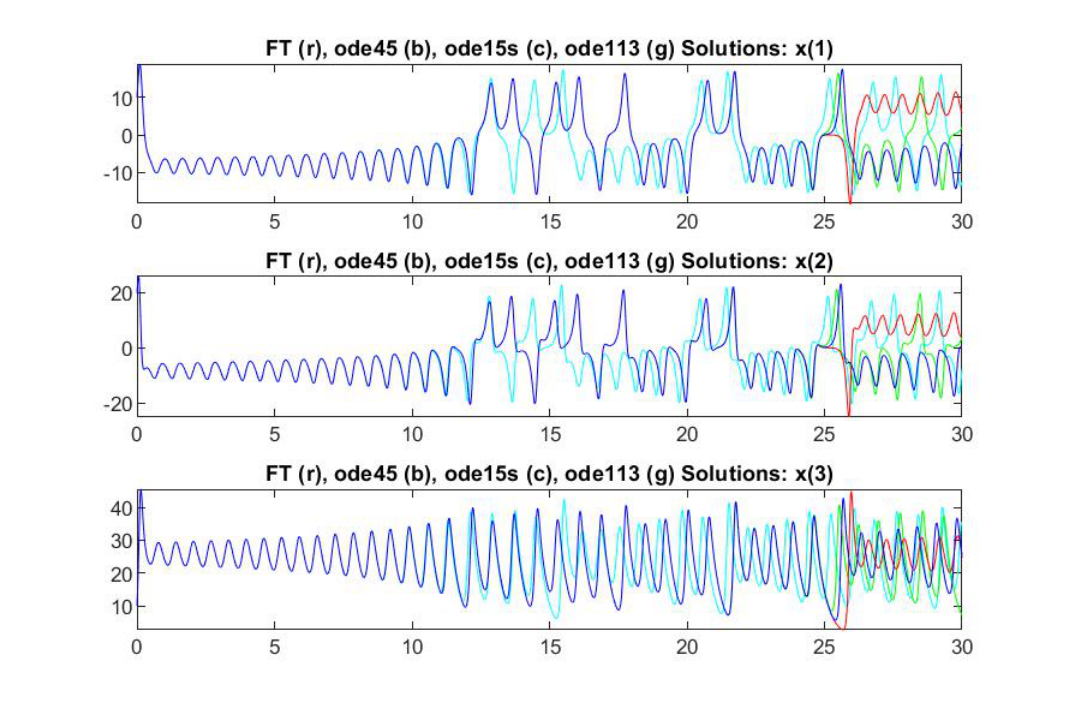
Figure 7. Problem No4 (Lorenz system): The three components x j ( t ) , j = 1,2,3 are obtained also by routines ode15i (cyan color) and ode113 (green color); FT solution is red-colored, RK solution is blue-colored. Remark that differences between the solutions of this system are essentially due to very small differences in the solutions found by the different